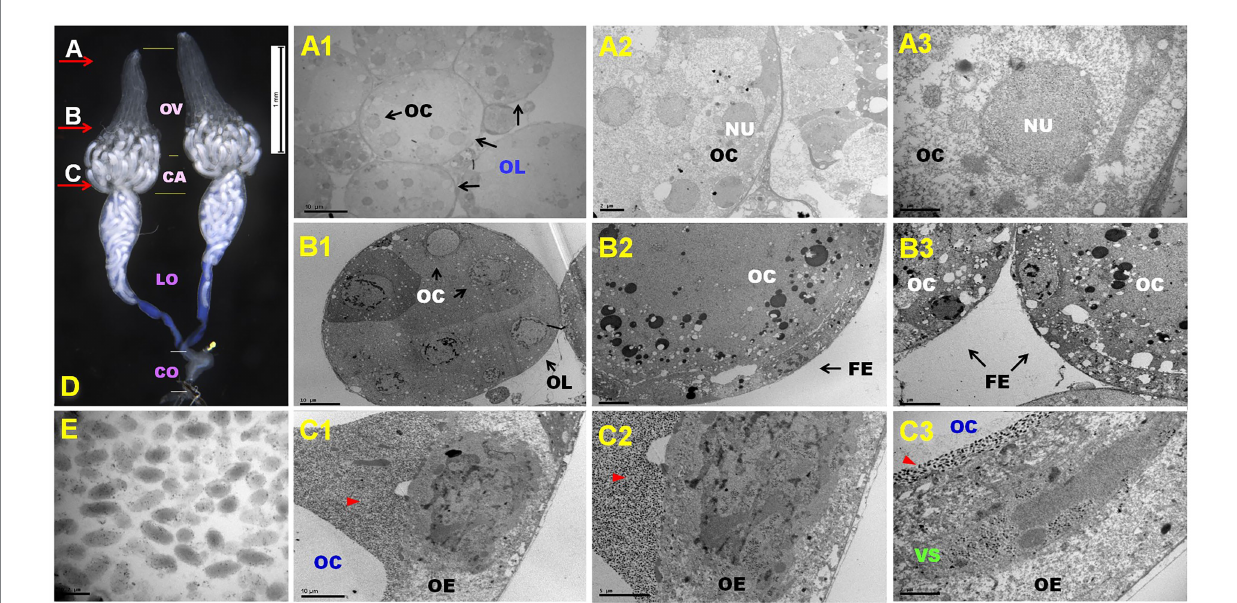
FIGURE 1 (A–E) Representative ovary structure of Diadegma fenestrale (D); red arrow indicates the dissection position and direction of the cutting sites (A–C) . The reproductive organ comprised four major parts: ovary (OV), calyx (CA), lateral oviduct (LO), and common oviduct (CO). Cutting site (A) : oogenesis at the germarium of the D. fenestrale ovary (A1–A3) . A single ovary contained about 10 ovarioles. More than five immature oocytes (OC) were located in each ovariole (OL) (A1) . A detailed view of the ovariole is shown in (A2) . Five oocytes and their nuclei (NU) were observed in an ovariole. A detailed view of the oocyte is shown in (A3) . Cutting site (B) : OCs in vitellogenesis are surrounded by the follicular epithelium (FE). Six OCs were present in an OL (B1) . A detailed view of the OCs is shown in (B2,B3) . Cutting site (C) : OCs surrounded by virion particles at the calyx area after vitellogenesis. The ovarian epithelium (OE) contains virogenic stroma ( VS ) and releases the virion particle to the calyx chamber. Red triangles indicate the presence of DfIV particles (C1,C2) . DfIVs were located within the OE with OCs (C3) . Newly growing oocytes were abundant at the ovarian calyx and lateral oviducts ( D ). DfIV showed a double membrane envelope, but the inner membrane could not be distinguished clearly (E)